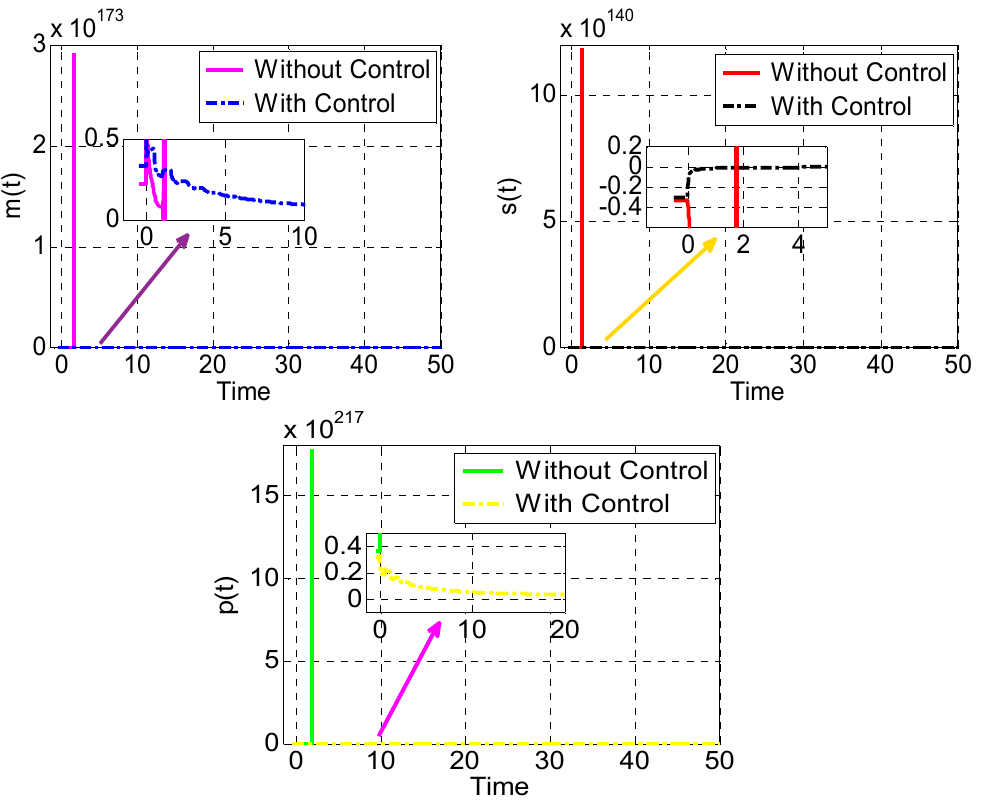
Figure 8. Contrasting time response of the three-dimension FOGRN when 0.5. α =